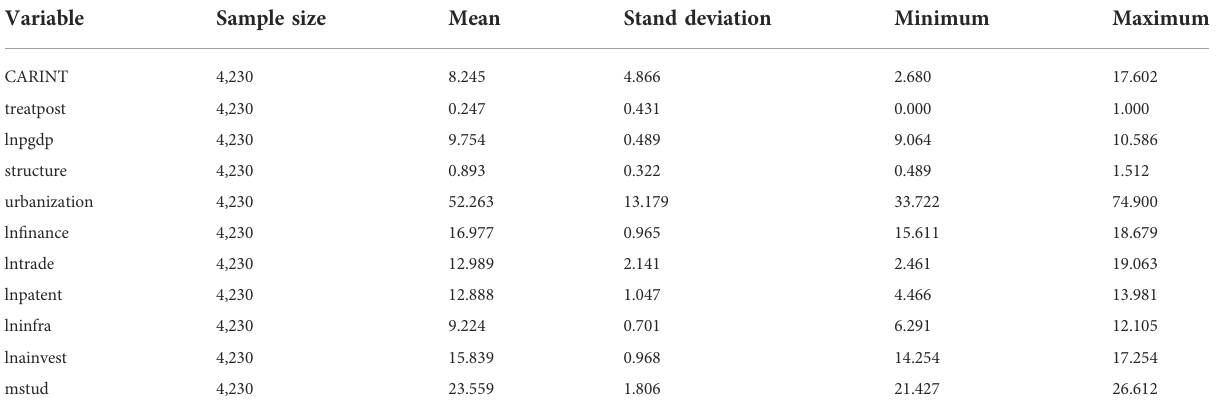
TABLE 2 Descriptive statistics of the main